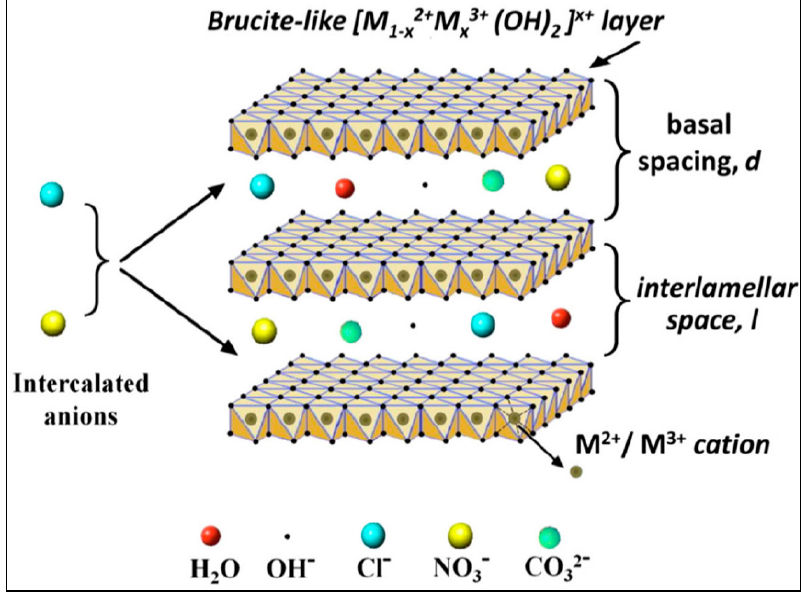
Figure 1. Three dimensions tunable LDH interlayer structure [20].